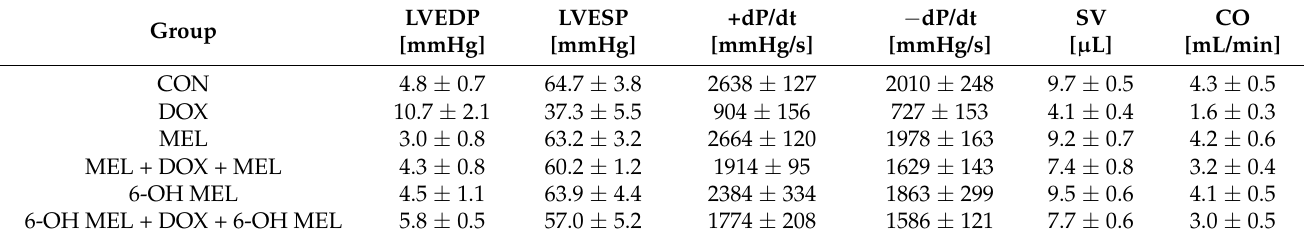
Table 15. Effect of melatonin (MEL) and 6-OH MEL on cardiac function in DOX-treated mice